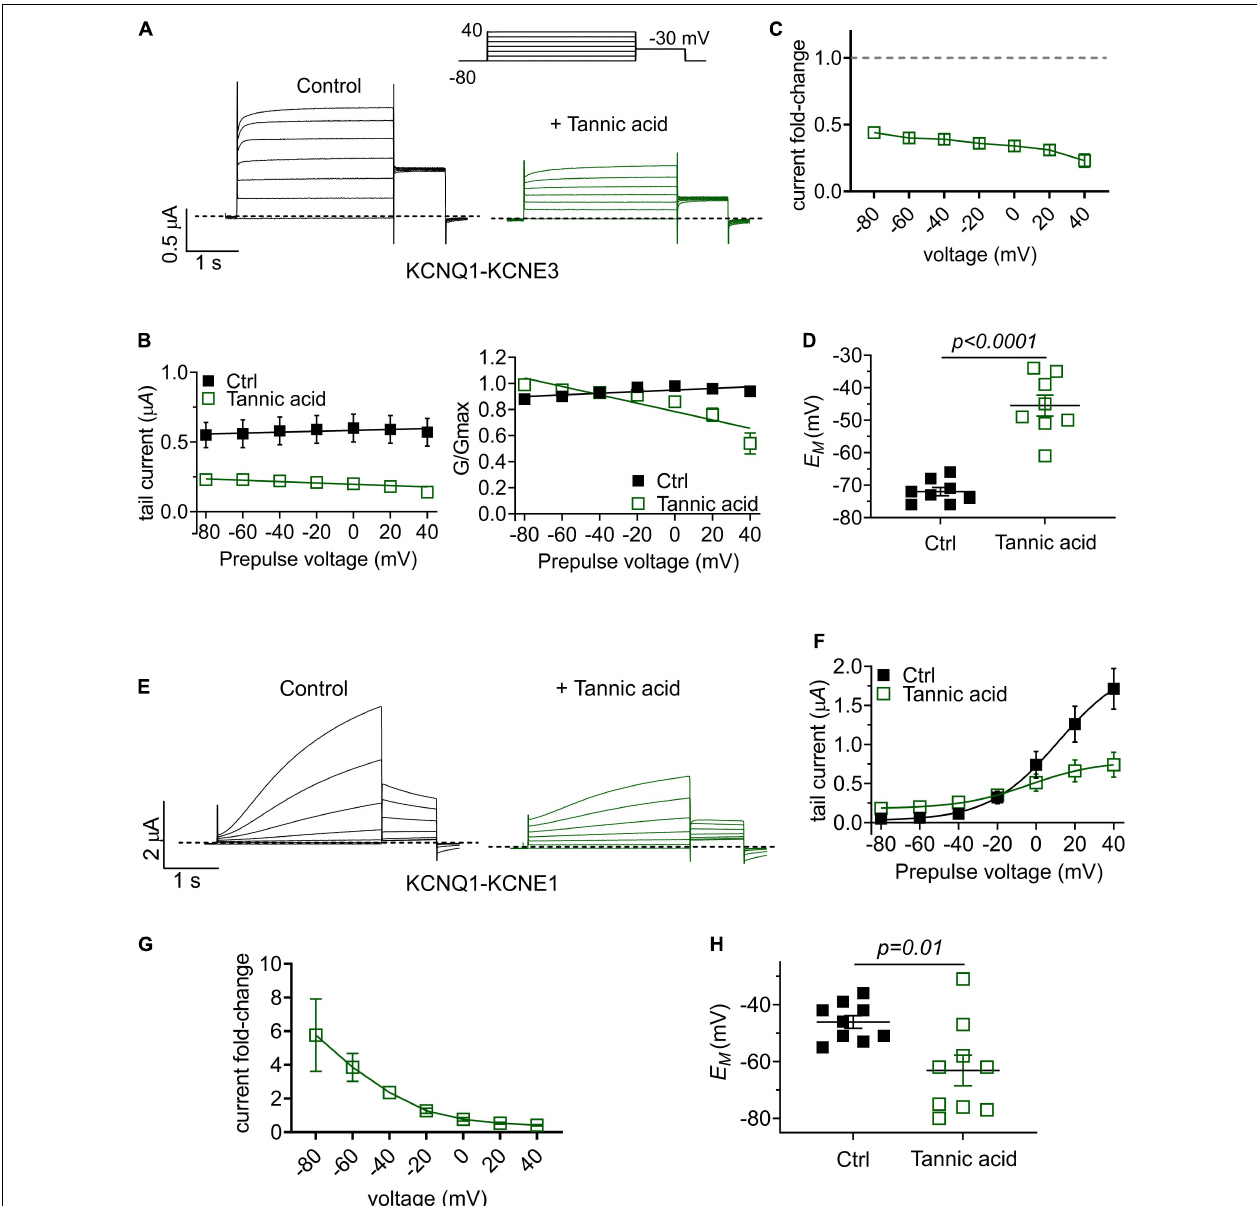
FIGURE 10 | Tannic acid exerts KCNE-specific effects on KCNQ1 channel complexes. (A) Exemplar TEVC traces of oocyte-expressed KCNQ-KCNE3 channels in the absence (control) and presence of tannic acid (100 µ M) ( n = 8). (B) Mean tail current (left) and normalized tail current (G/Gmax; right) versus prepulse voltage relationships for traces as in panel (A) ( n = 8). (C) Tannic acid-induced tail current fold-change versus prepluse voltage for oocytes as in panel (A) . (D) Scatter plot of unclamped membrane potential ( E M ) for KCNQ1-KCNE3-expressing oocytes as in panel (A) in the absence (Ctrl) or presence of tannic acid (100 µ M). Statistical analysis by one-way ANOVA. (E) Exemplar TEVC traces of oocyte-expressed KCNQ-KCNE1 channels in the absence (control) and presence of tannic acid (100 µ M) ( n = 9). (F) Mean tail current versus prepulse voltage relationships for traces as in panel (E) ( n = 9). (G) Tannic acid-induced tail current fold-change versus prepluse voltage for oocytes as in panel (E) . (H) Scatter plot of unclamped membrane potential ( E M ) for KCNQ1-KCNE1-expressing oocytes as in panel (E) in the absence (Ctrl) or presence of tannic acid (100 µ M). Statistical analysis by two-way